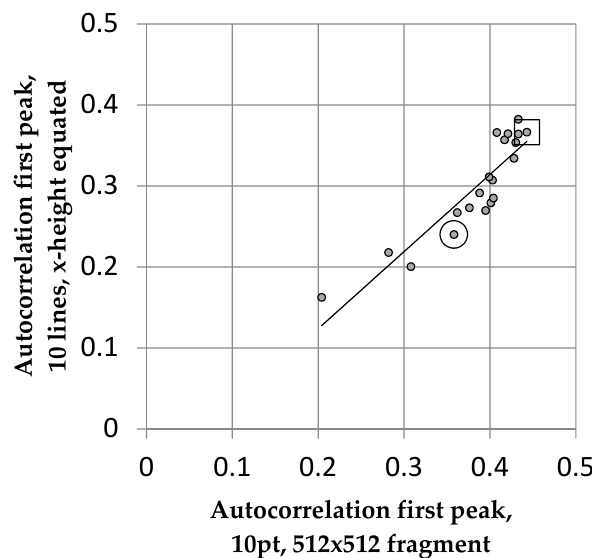
Figure 4. Correlation between text from Trollope 10 pt with 1.15 pt interline spacing and the same passage normalised for x-height, for the 20 fonts listed in Table 1. The points for Open Sans and Times are surrounded by a circle and a square respectively.